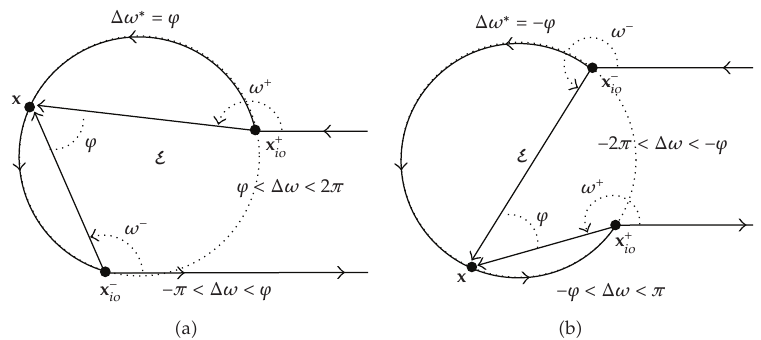
Figure 6: Qualitative behaviour of the phase di ff erence Δ ω . Notice that if the point x (cid:6) (cid:22) , then Δ ω (cid:9) > 0. The angle Δ ω (cid:9) holds identically (cid:6) ϕ (cid:2) a (cid:3) or − ϕ (cid:2) b (cid:3) counterclockwise on C i (cid:2) t (cid:3) to reach x − io (cid:22) on C i (cid:2) t (cid:3) (cid:2) bold line (cid:3) .